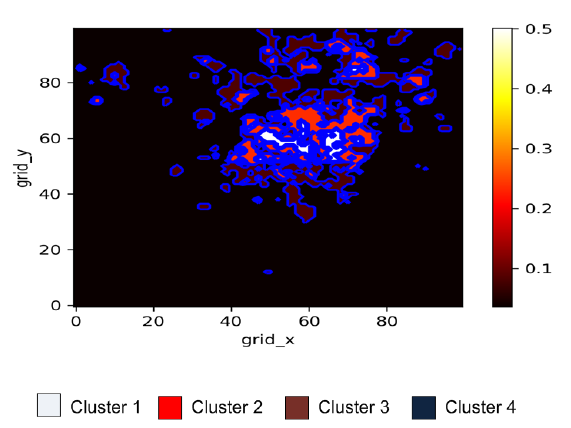
Figure 12. GMM Clustering.